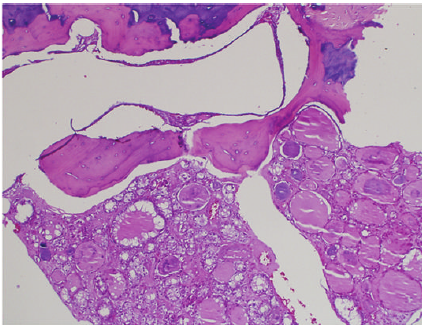
Figure 2: HE × 4 showing tumor invading